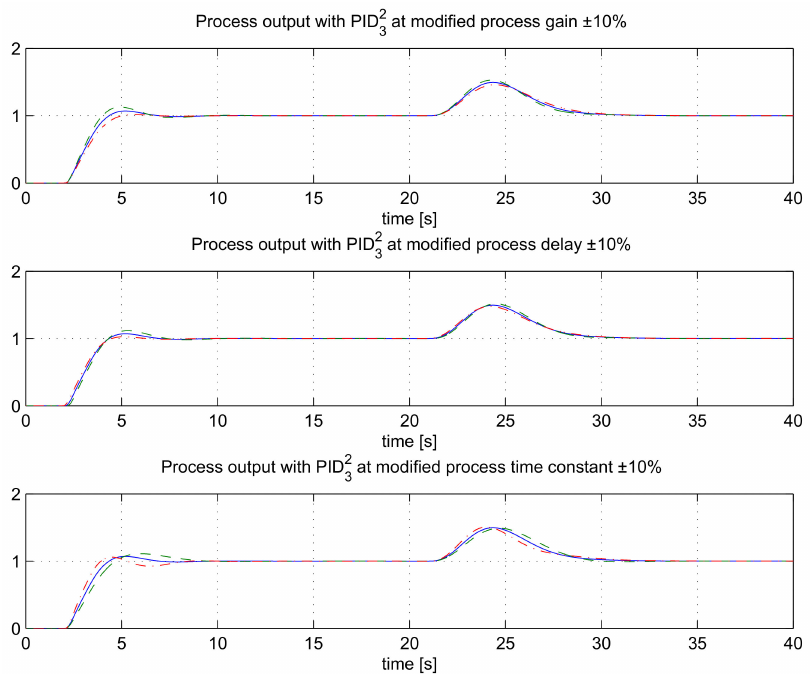
Figure 10. The closed-loop responses for the process G P 4 ( s ), using controller PID 2 for nominal (solid line), 10% increased (dashed line) and 10% decreased (dash-dotted line) process